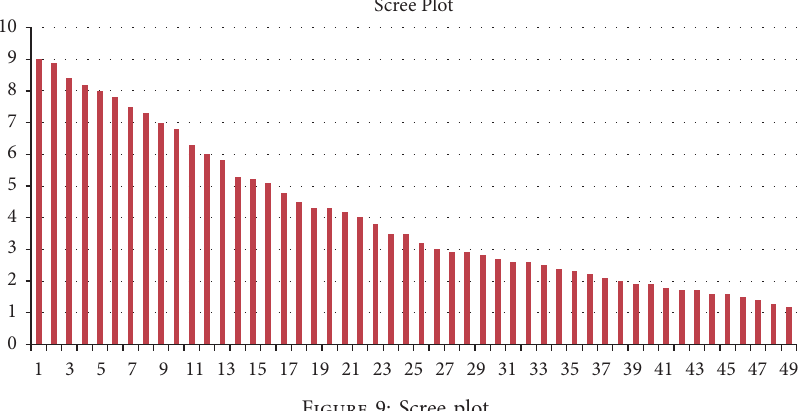
Figure 9: Scree plot.